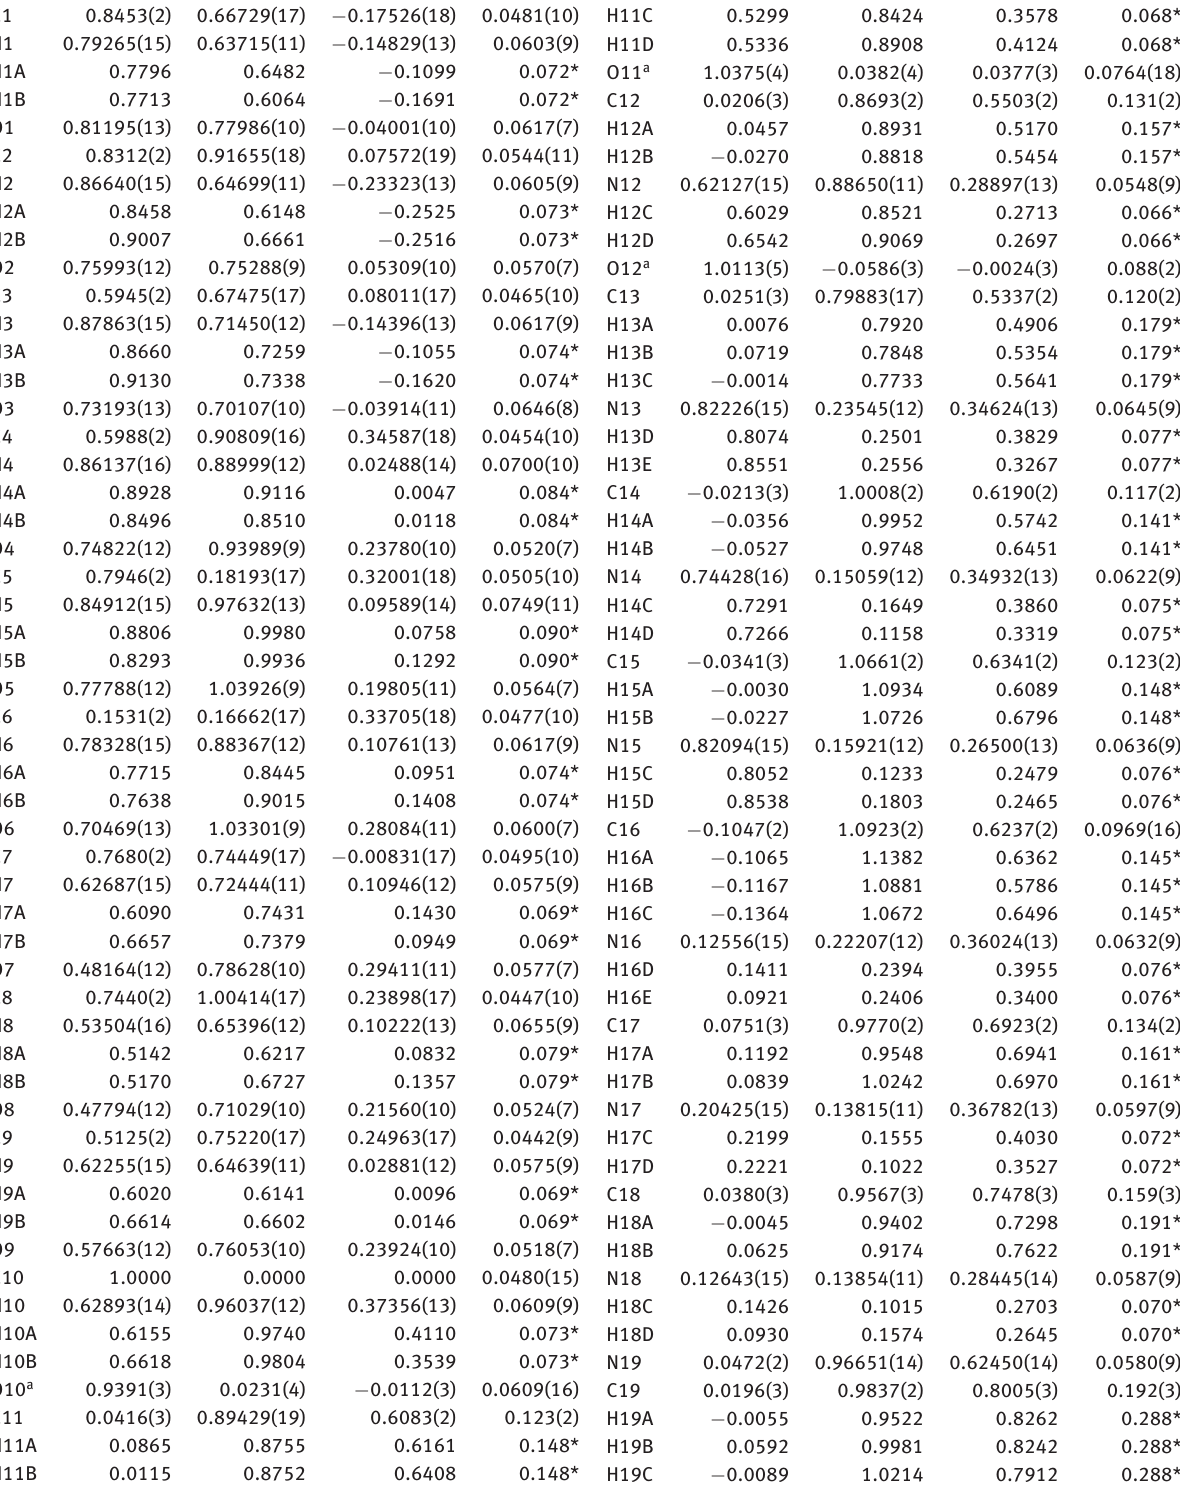
Table 2: Fractional atomic coordinates and isotropic or equivalent isotropic displacement parameters (Å 2